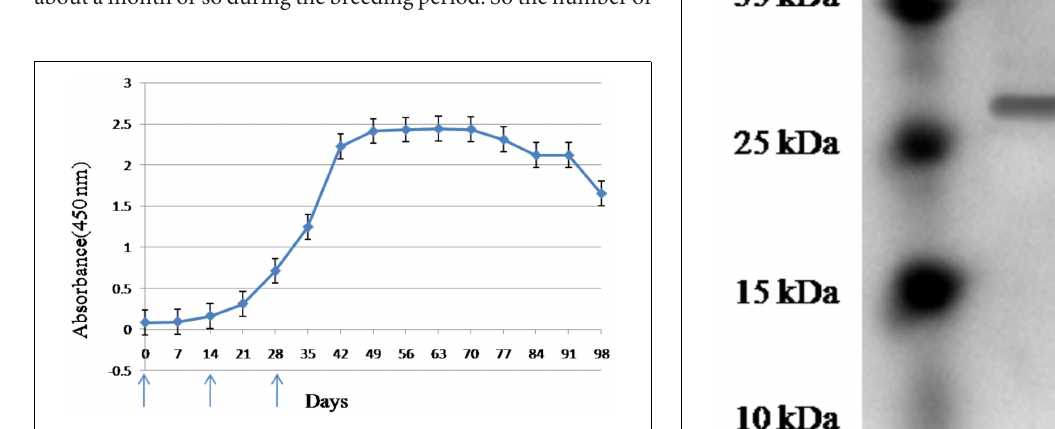
FIGURE 1 | Antibody response in serum of laying hens immunized with CSBV. Anti-CSBV activity was determined by ELISA. The specific antibody levels began increasing in the serum 14 days after the first immunization, reaching a peak on day 42, and remaining high until day 91. Arrows represent the time of immunization; bars represent SE.